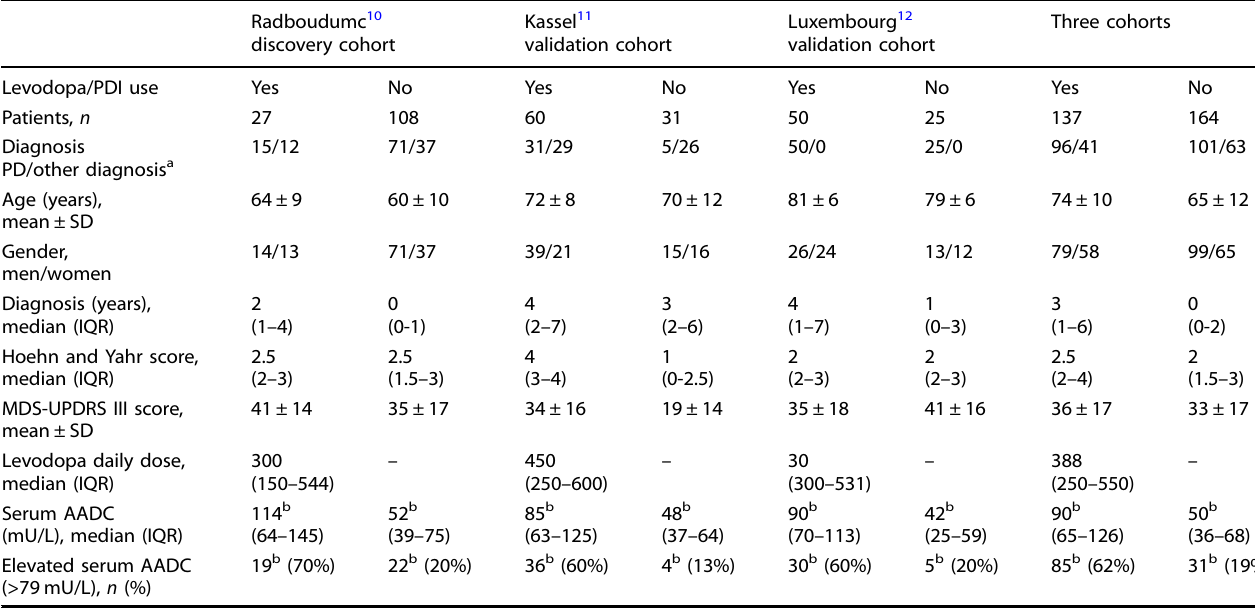
Table 1. Baseline characteristics of Radboudumc, Kassel, and Luxembourg